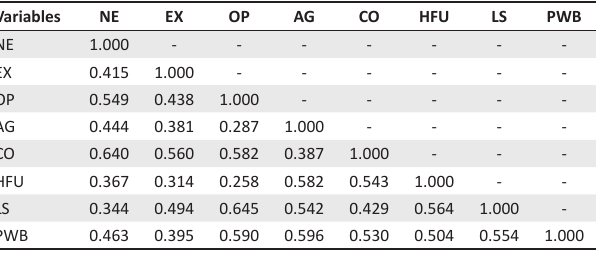
TABLE 4: Discriminant validity (hetero-trait-monotrait-ratio).